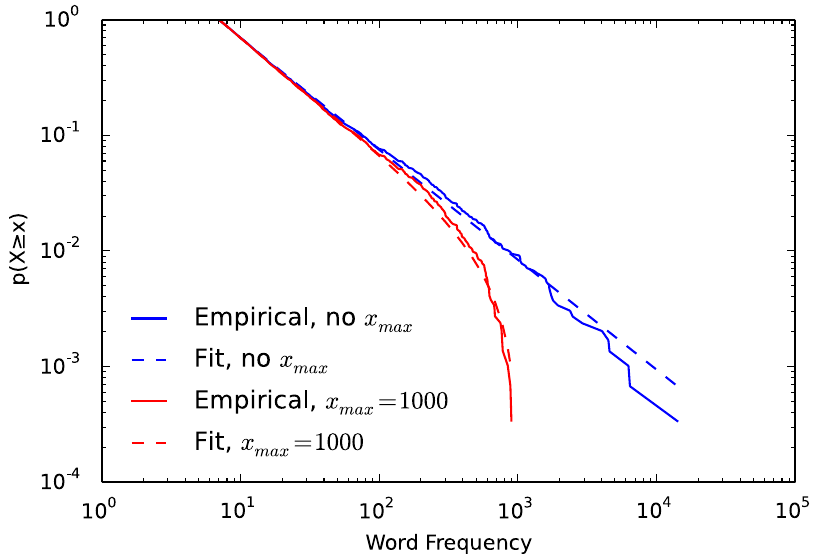
Figure 3. Complemenatary cumulative distribution functions of the empirical word frequency data and fitted power law distribution, with and without an upper limit x max